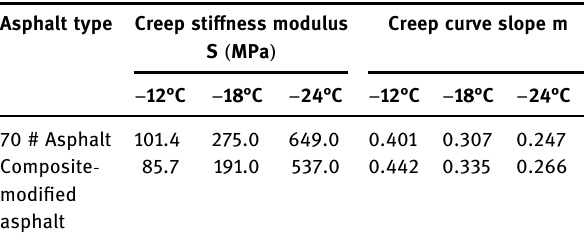
Table 8: Freeze - thaw test results of cement stabilized gangue